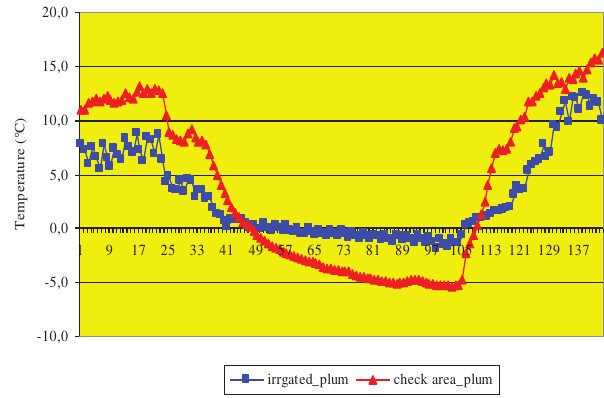
Figure 6 – Temperatures as changing in the spraying experiment with